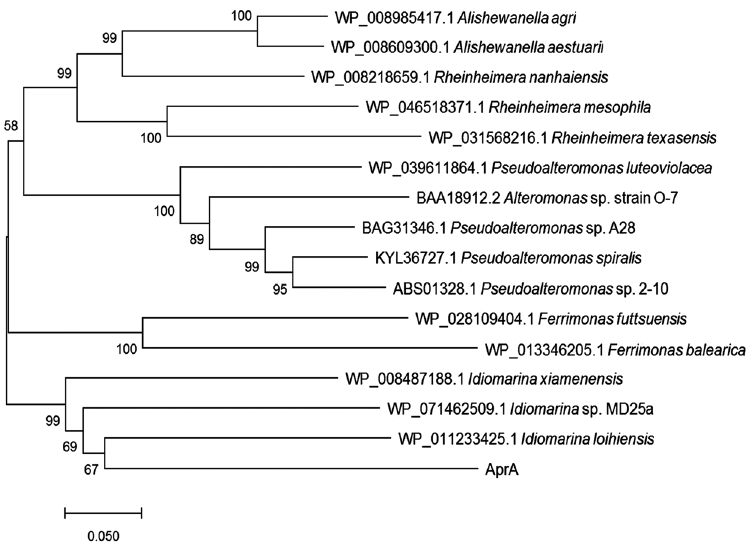
Figure 1. Phylogenetic analysis of AprA and other highly homologous proteases based on amino acid sequences. The GenBank accession No. for each serine protease is in front of the Latin name of each strain. The unrooted Neighbor-Joining tree was inferred using the MEGA 7.0 software. The percentage of replicate trees in which the associated taxa clustered together in the bootstrap test (1000 replicates) is shown next to the